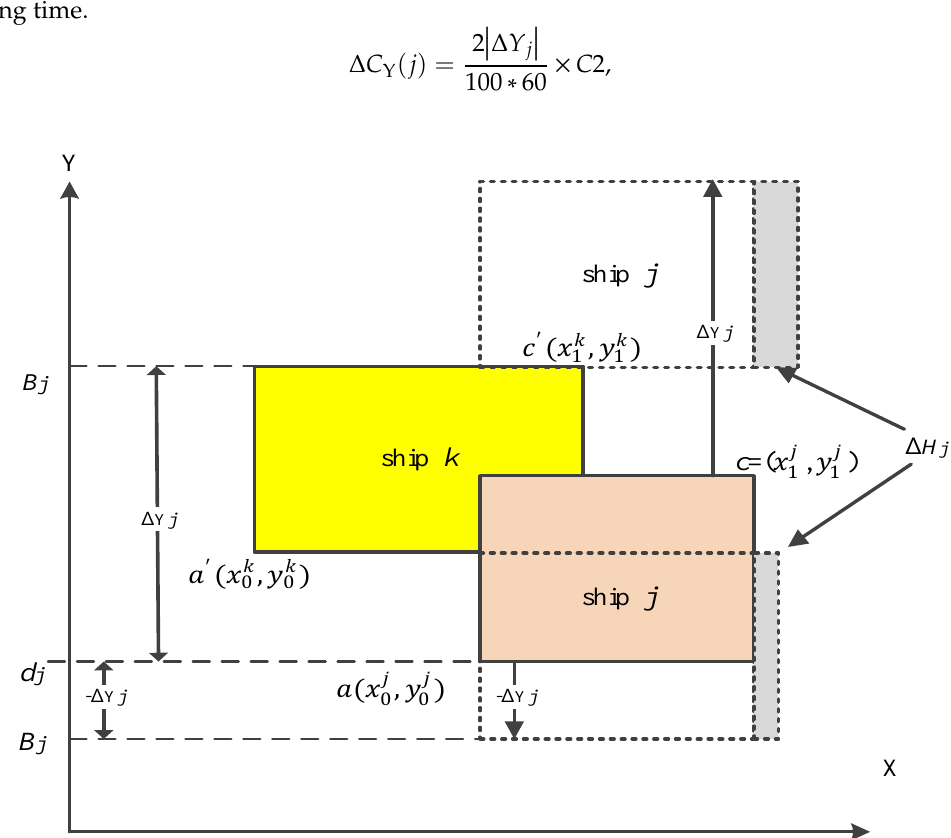
Figure 8. Increasing the target ship j ’s handling time when moving towards +Y/−Y.